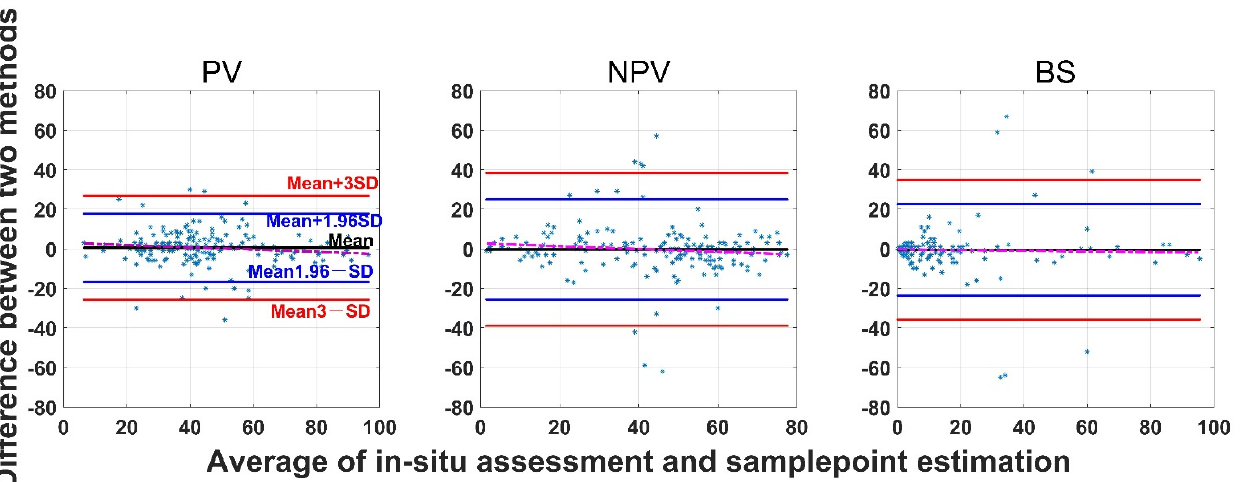
Figure 5. Bland-Altman plot of the difference between SamplePoint estimation and in situ assessment for PV, NPV, and BS fraction covers. Refer to the left panel for threshold values. The red dotted line is the regression between the two-method mean and the two-method difference. Table 1. Mean, standard deviation (SD), and mean ± 1.96 (or 3) SD of the differences between in situ assessment and four imagery methods (SamplePoint estimation, unsupervised classification, supervised classification, and